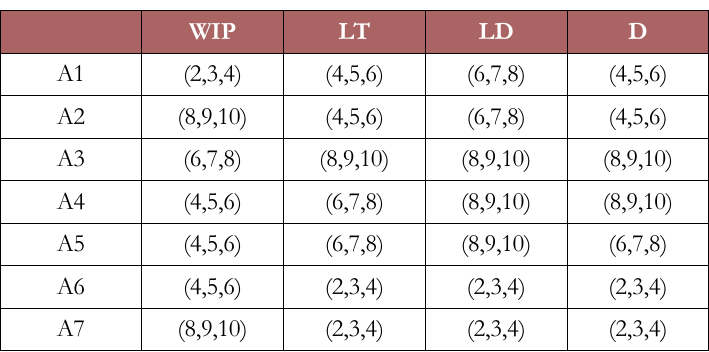
Table 8. Fuzzy evaluations matrix for solutions